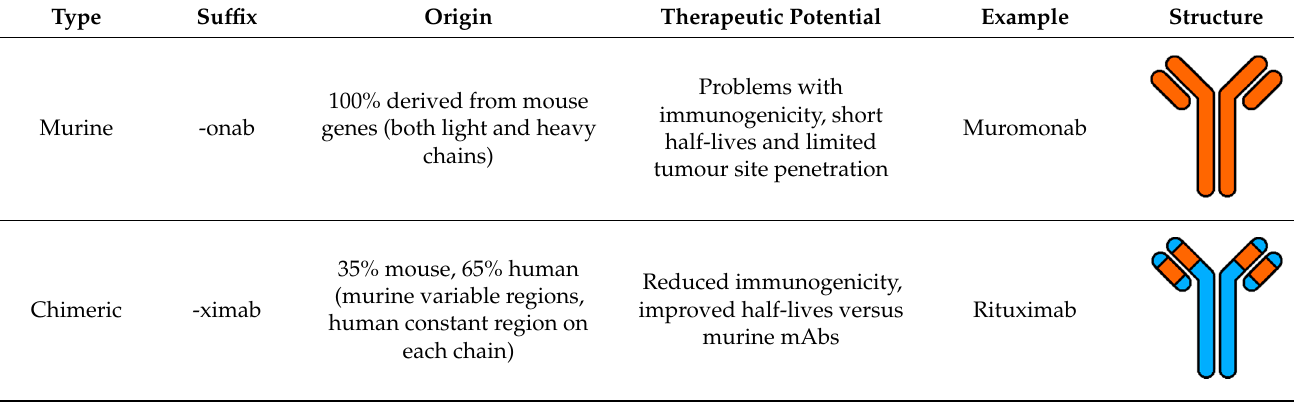
Table 1. Types of monoclonal antibody [24]. Key : human-derived mAb regions shown in blue; mouse-derived (or for humanised mAbs, synthetic/animal-derived) mAb regions shown in orange.